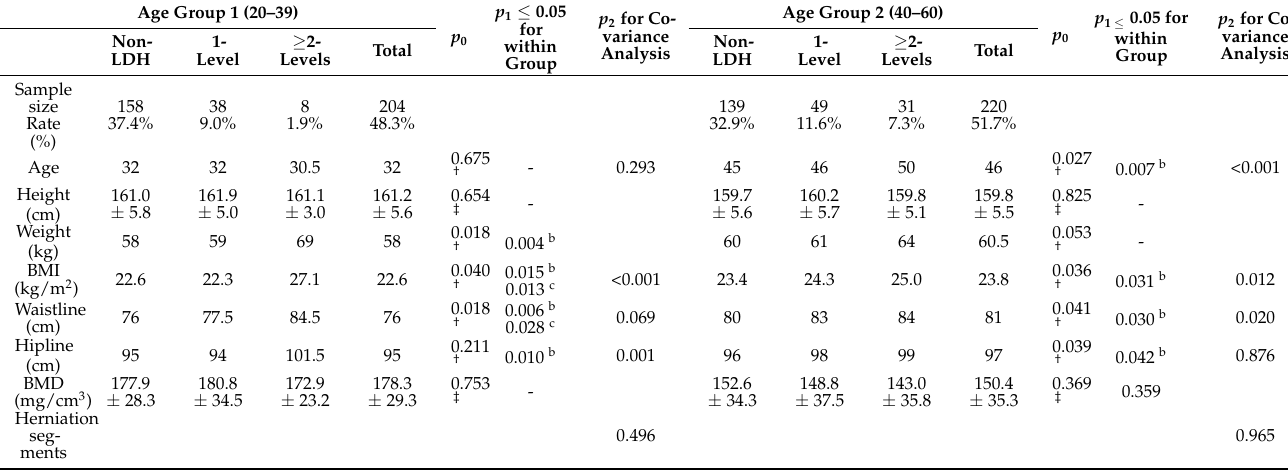
Table 3. Comparison of characteristic and Trab.vBMD data between different disc condition in younger and older women. Age Group 1 (20–39)